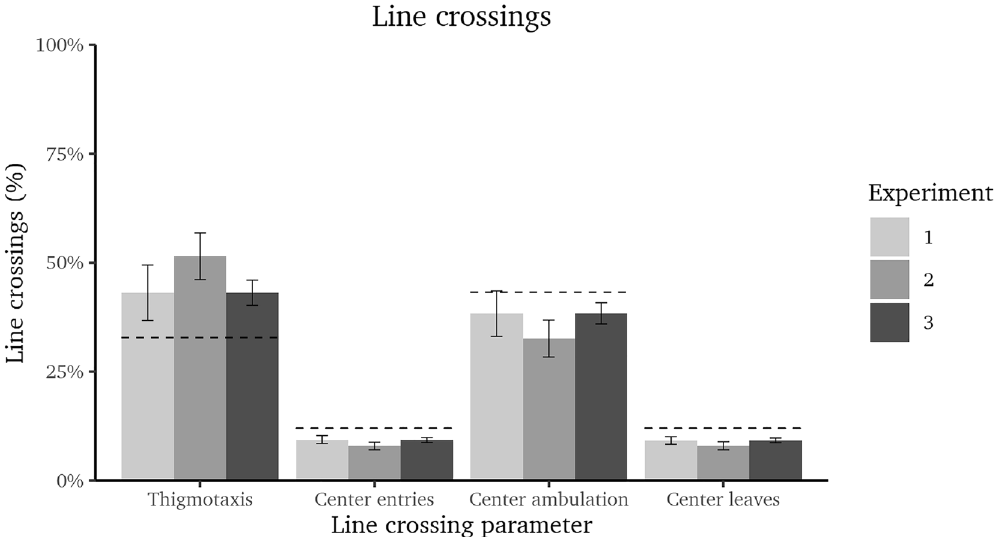
Figure 4. Proportion of thigmotaxis, center entries, center ambulation, and center leaves in total line crossings (± 95% CI; indicates significance if the CI does not include the respective expected value (dashed